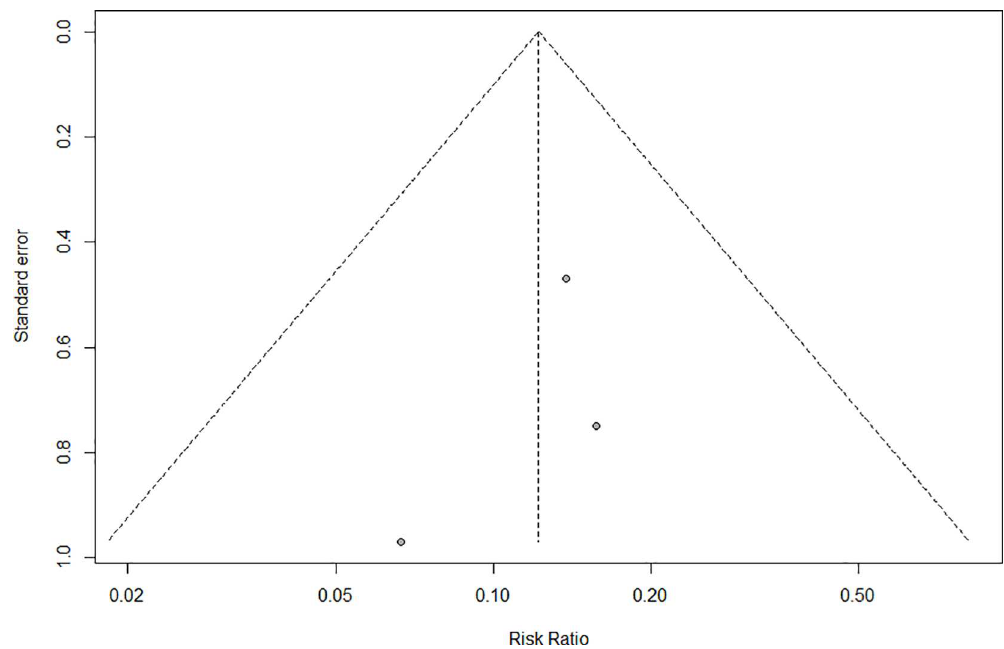
Fig 3. Funnel plot showing that the studies were mostly spread around the midline of the